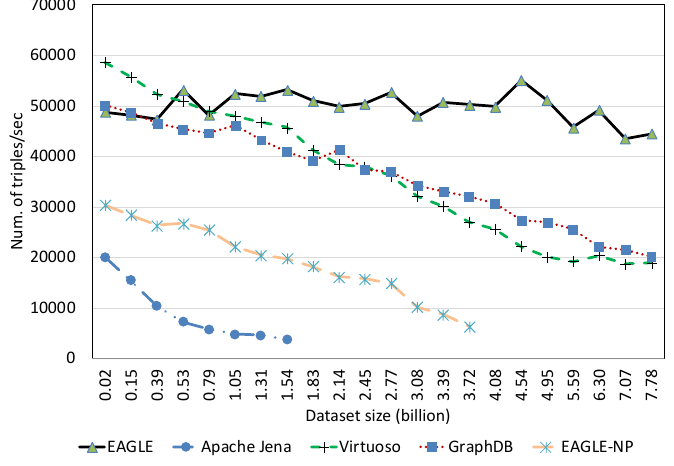
Figure 17. Average temporal indexing throughput. Temporal loading time